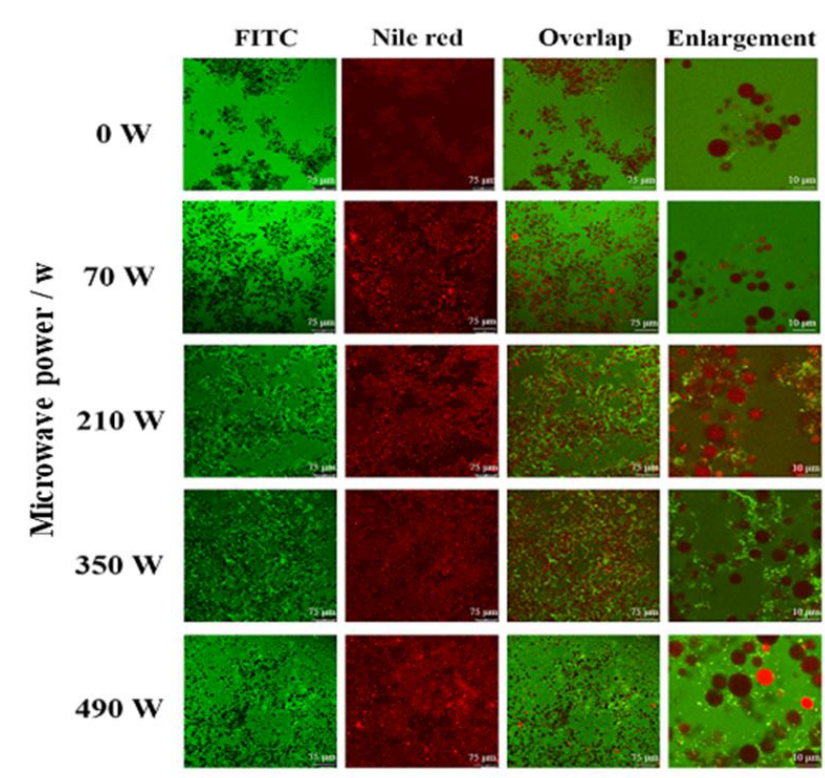
Figure 5. CLSM of the lysozyme-oregano essential oil (LZ-OEO) bacteriostatic gels after microwave treatment. FITC represents isothiocyanine fluorescein; Nile red represents Nile red fluorescein; Overlap represents the overlapping diagram of two fluorescence signals; Enlargement represents a partial enlargement.